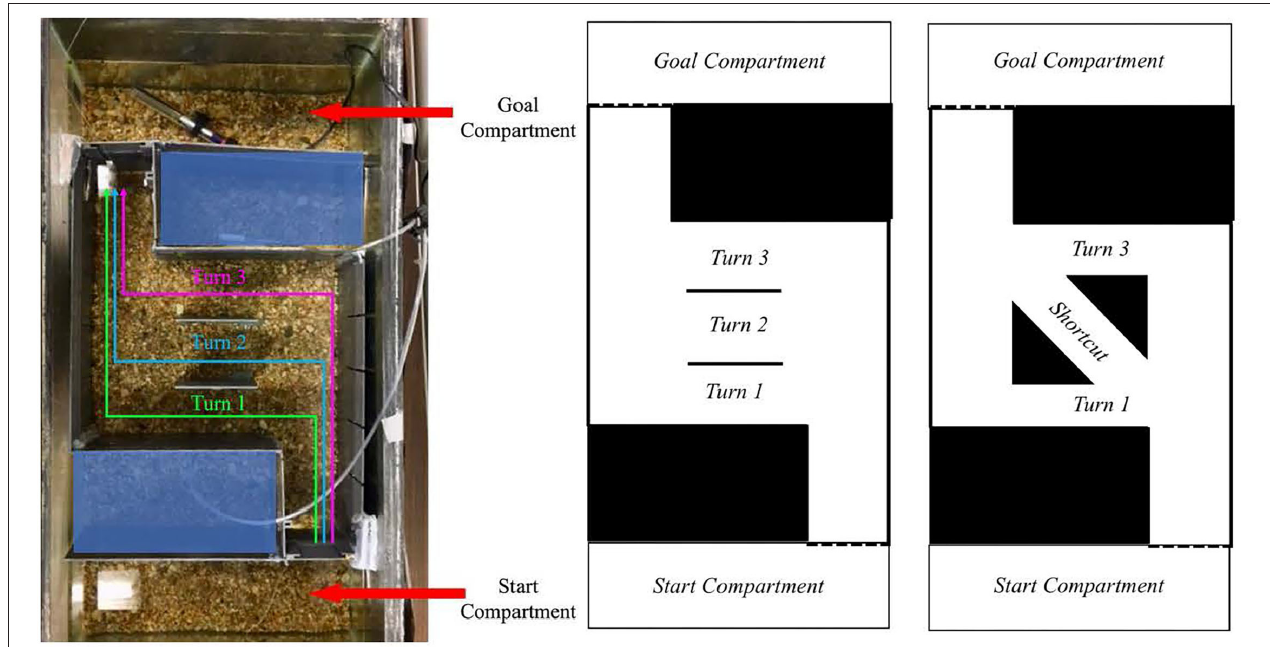
FIGURE 1 | (Left) Overhead view of the fish tank during a test trial. There were three possible turn options, all of equivalent length. During familiarization, the middle two walls, which create the turns, were not present. (Right) Schematic of the maze used and the proposed maze with a shortcut. Photo: Victoria Braithwaite; diagrams: Natalie